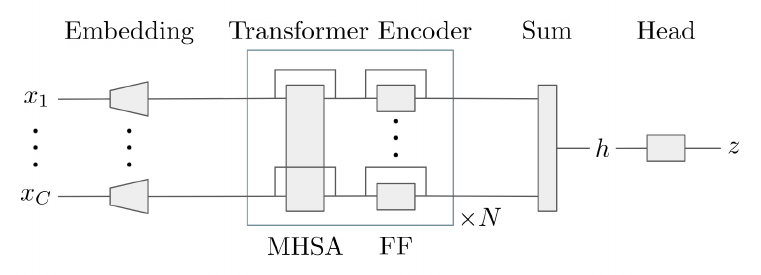
Figure 3: Illustration of the transformer network architecture. MHSA stands for multi-headed self-attention, and FF for a feed-forward block, as defined in the